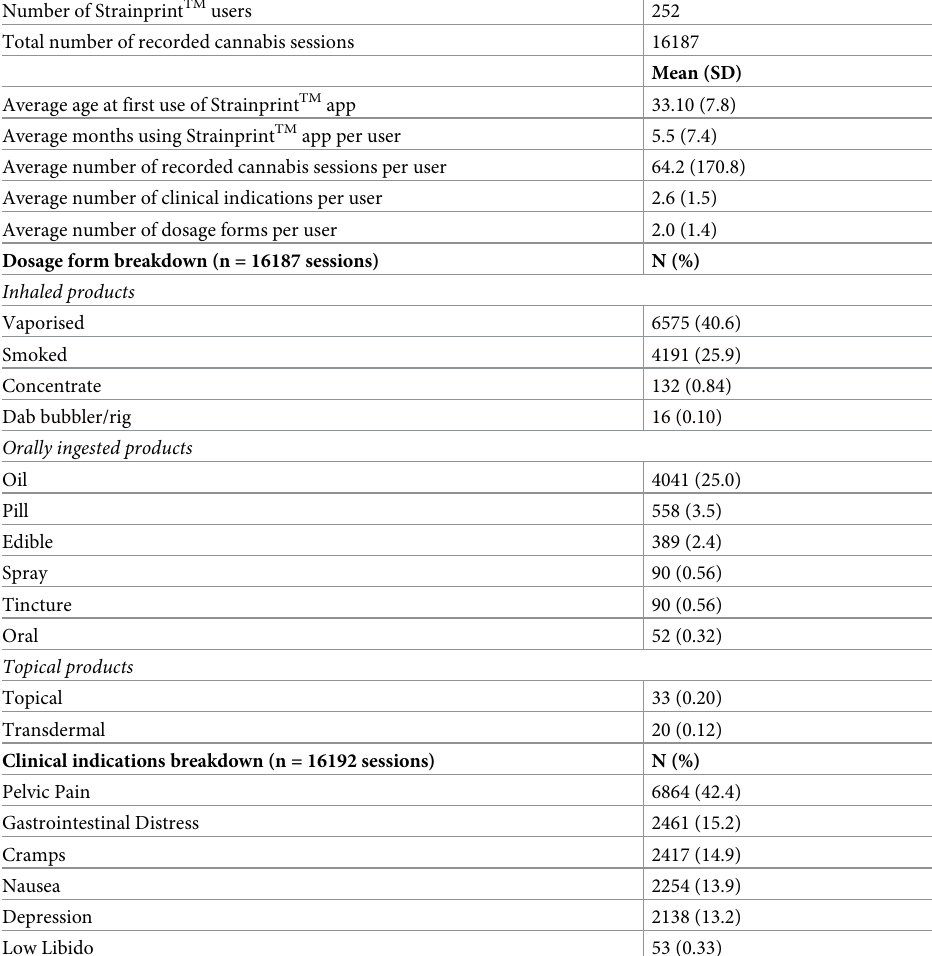
Table 1. Demographic of Strainprint TM users with